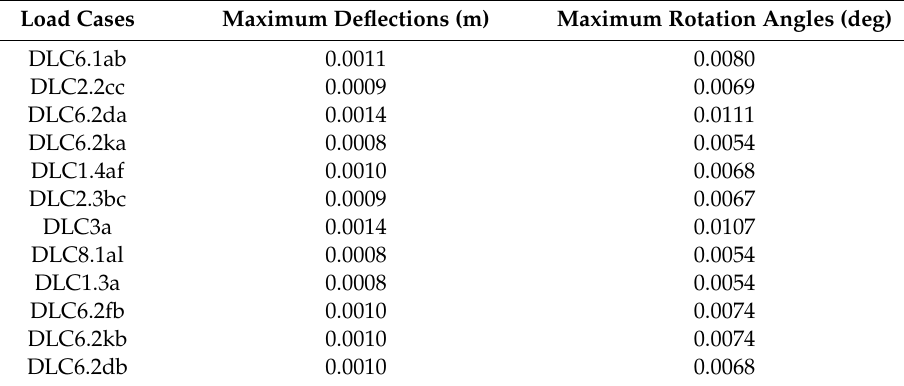
Table 7. Maximum deflections and rotation angles of the piles at the mud